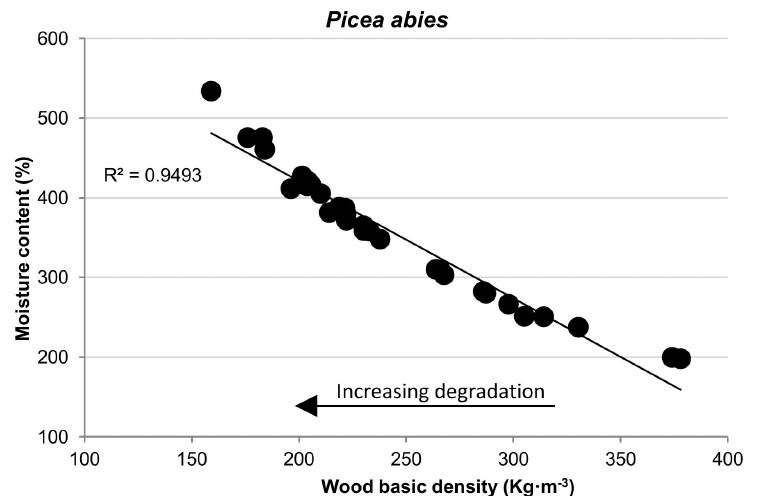
Figure 9. A strong linear relationship ( r 2 = 0.949) exists between wood basic density and moisture content increasing wood degradation ( n = 30) (author’s unpublished work). A quadratic polynomial seems to better explain the relationship between the two variables ( r 2 = 0.993), however, a linear is given here just for reasons of